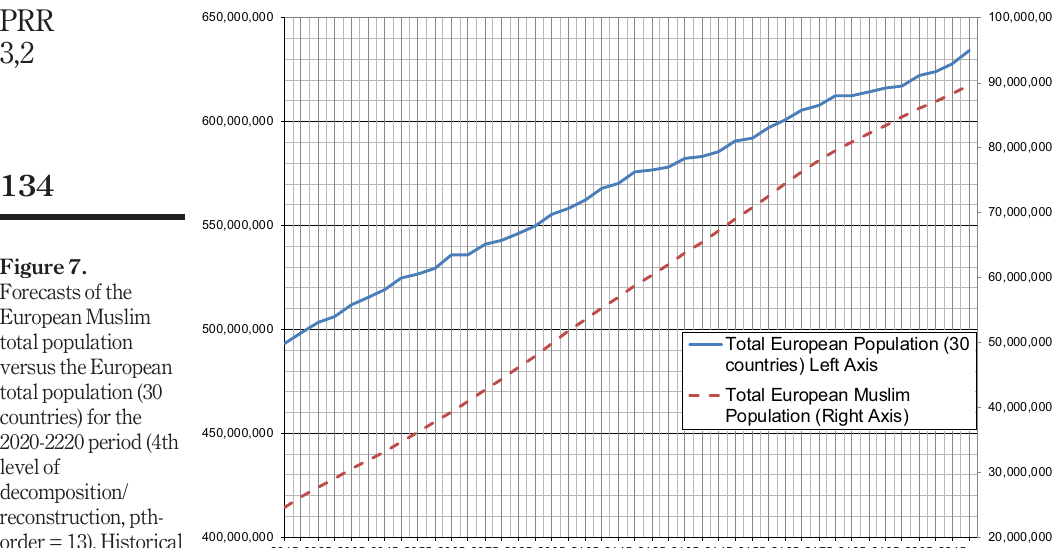
Figure 7. Forecasts of the European Muslim total population versus the European total population (30 countries) for the 2020-2220 period (4th level of decomposition/ reconstruction, pth- order = 13). Historical data from 1950